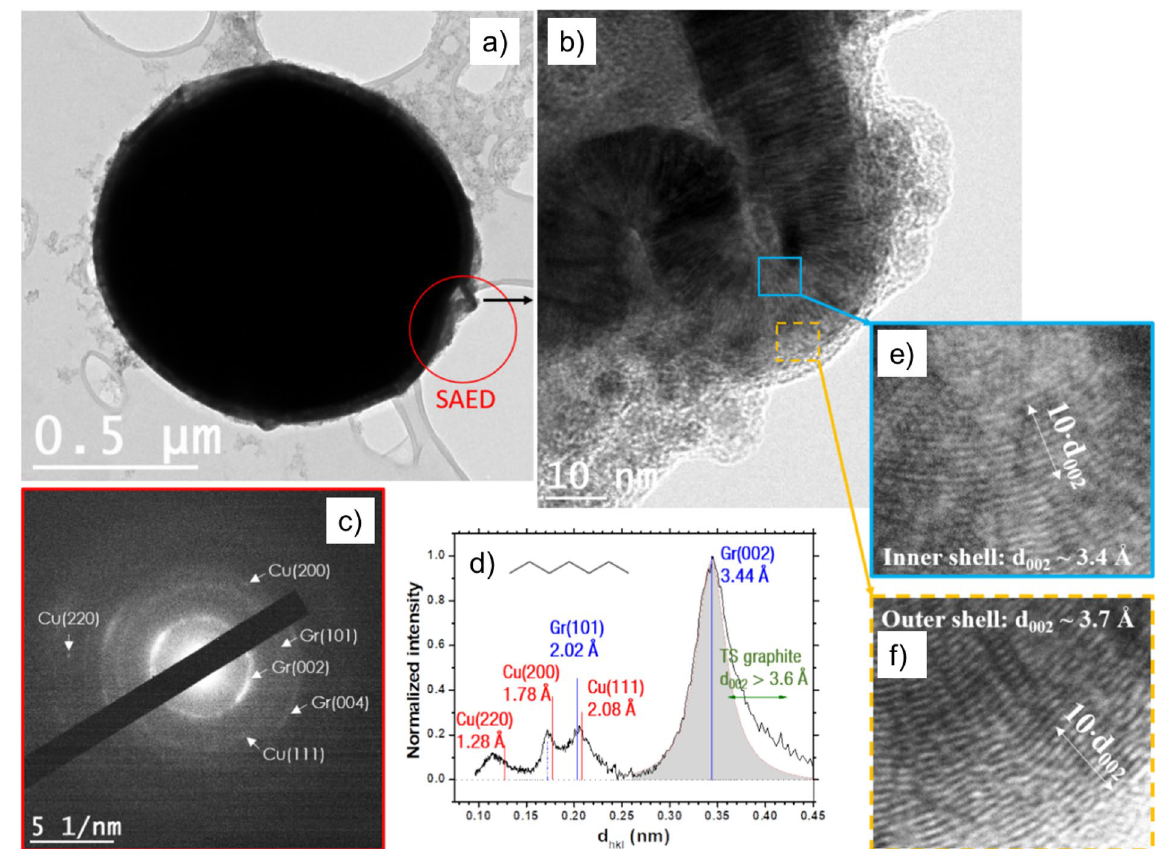
Figure 5. ( a ) High-resolution TEM image of a copper microscopic particle synthesized by discharges in heptane. ( b ) Higher magnification of ( a ) pointed by the black arrow. The insets present the inner ( e ) and outer ( f ) shell d 002 . ( c ) SAED pattern from ( a ) exhibiting Cu (200) reflections and Gr (002) and (100) rings. ( d ) A radially integrated profile permits to highlight Cu (111) reflections. The dotted blue line corresponds to the second-order Gr (002)